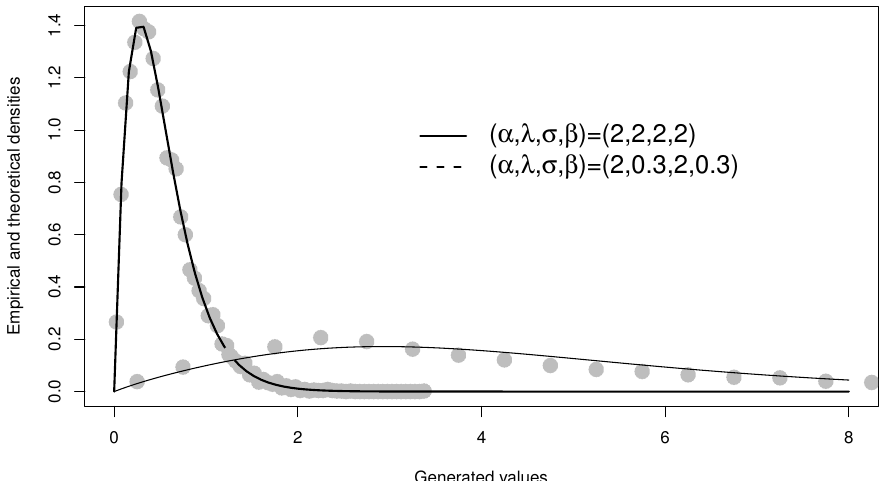
Figure 1. Estimated and empirical density from simulated